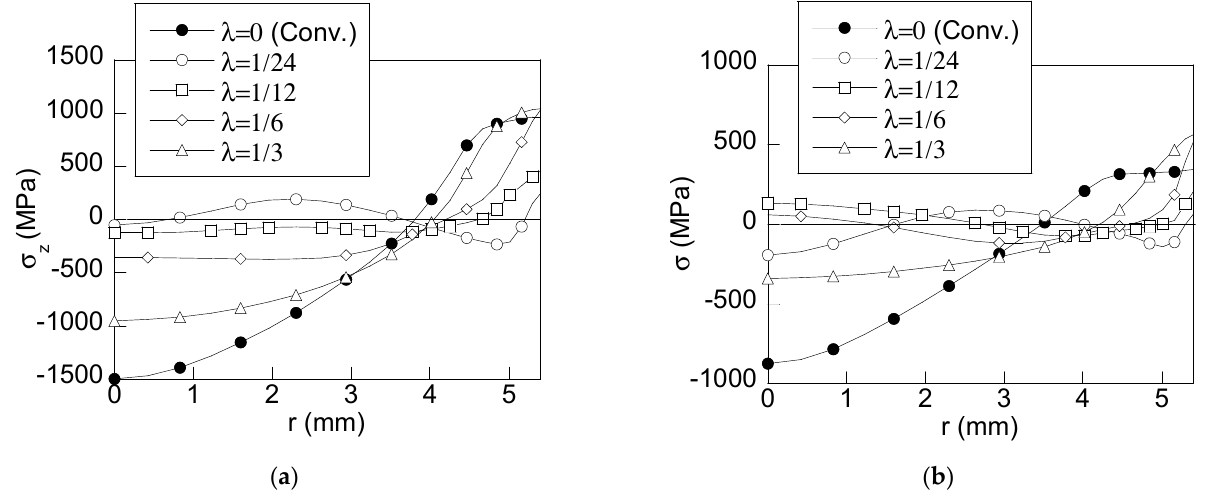
Figure 5. Radial distribution of the residual ( a ) axial stress and ( b ) hydrostatic stress, in cold drawn wires using diverse values of the secondary reduction ratio.